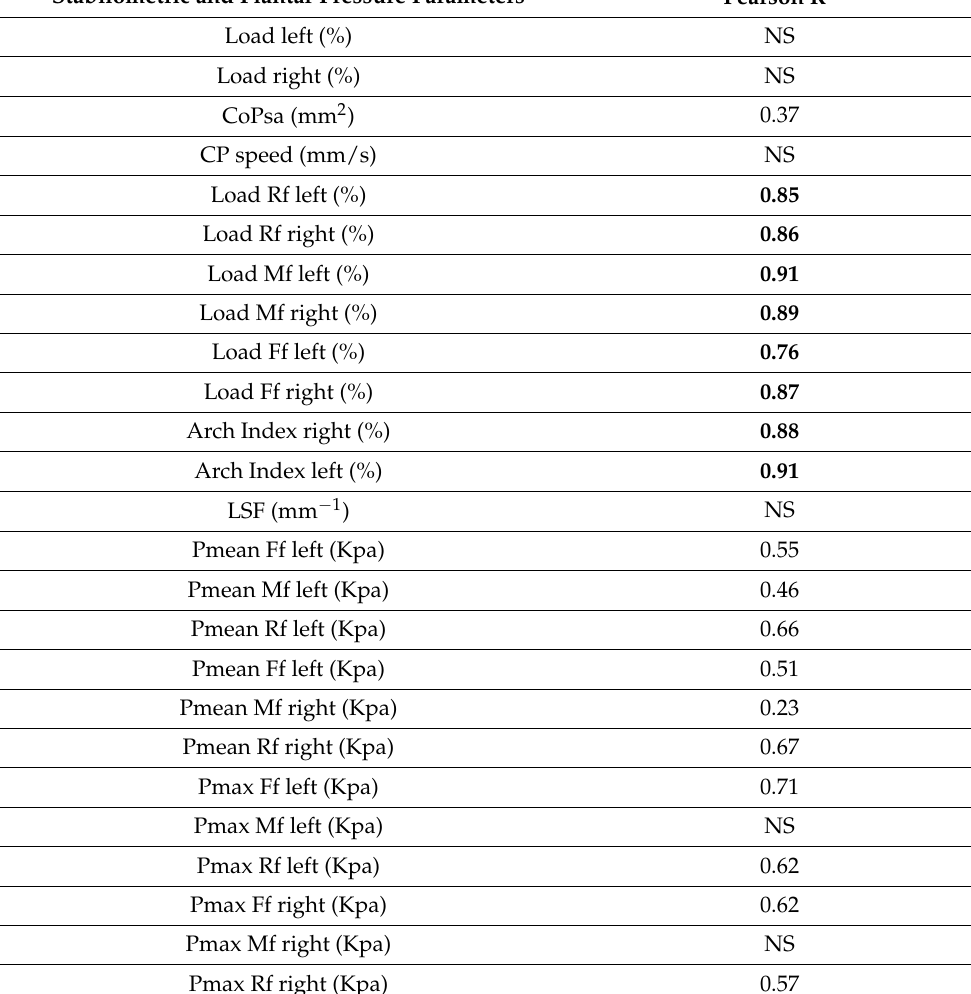
Table 1. Inter-session repeatability of measurements between the two sessions via Pearson’s (R 2 ) correlation coefficient for each parameter. NS indicates correlations not statistically significant ( p < 0.05). Statistically significant correlations (R 2 > 0.70) are highlighted in bold. Not significant (NS); forefoot (Ff); midfoot (Mf); rearfoot (Rf); mean pressure (Pmean); maximum pressure (Pmax); center-of-pressure sway area (CoPsa); center-of-pressure speed (CP speed); length surface function (LSF). Stabilometric and Plantar Pressure Parameters Pearson R 2 Load left (%) NS Load right (%) NS CoPsa (mm 2 ) 0.37 CP speed (mm/s) NS Load Rf left (%) 0.85 Load Rf right (%) 0.86 Load Mf left (%) 0.91 Load Mf right (%) 0.89 Load Ff left (%) 0.76 Load Ff right (%) 0.87 0.88